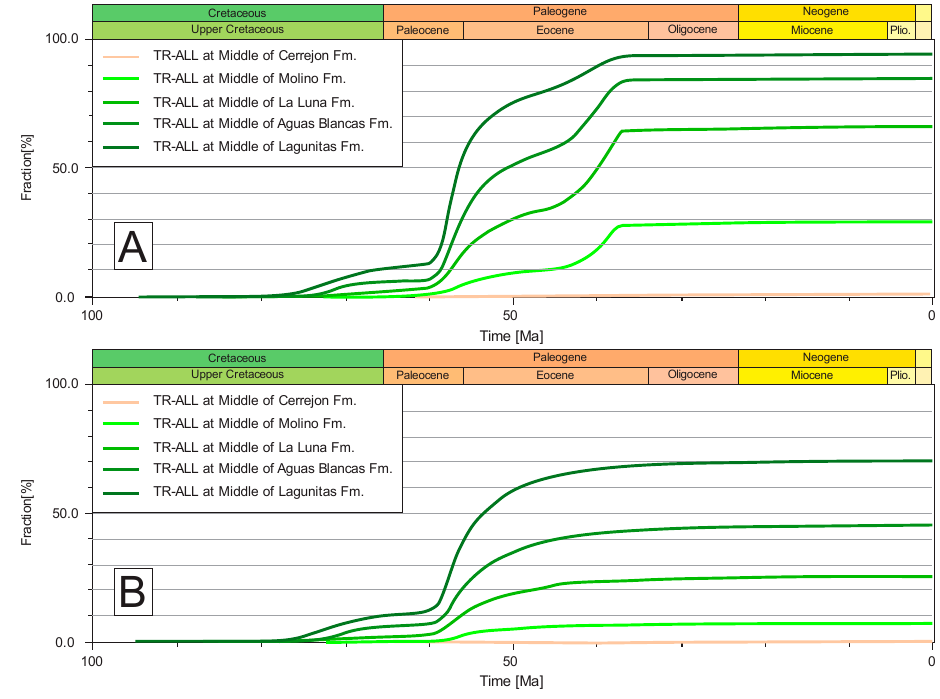
Figure 18. Hydrocarbon middle-component and transformation ratios (TR) for the Cretaceous and Paleogene formations in the ( A ) ANH-CARRETALITO-1 and ( B ) ANH-CAÑABOBA-1 wells.